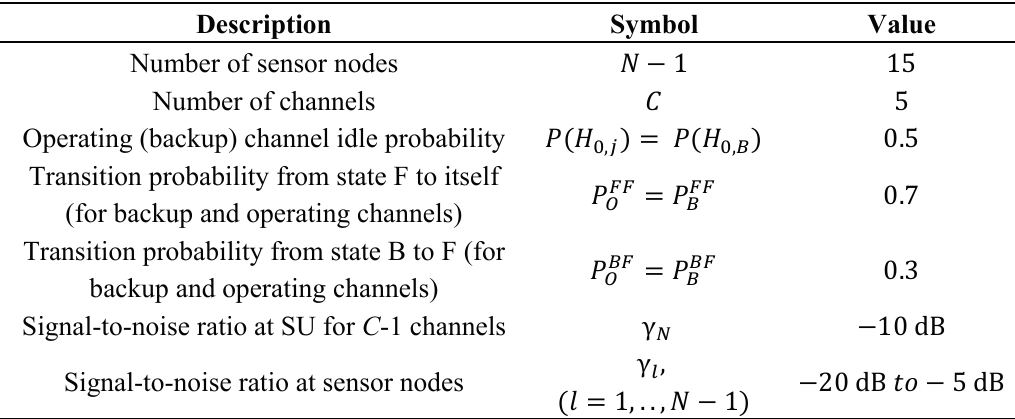
Table 2. Simulation